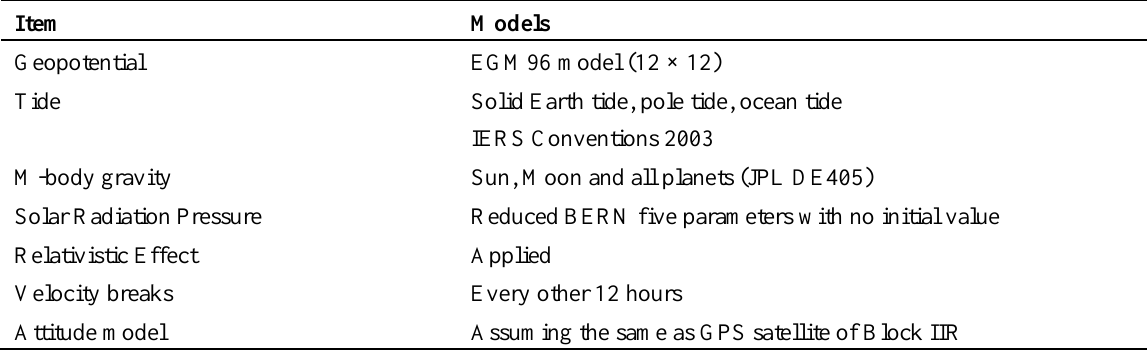
Table 3. Dynamic models involved for BeiDou orbit